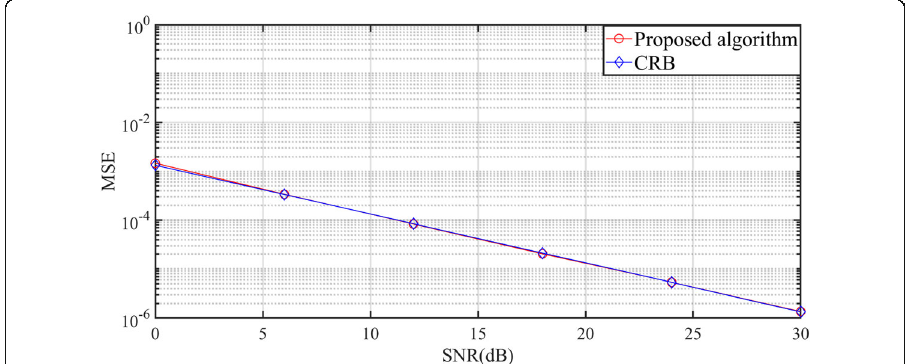
Fig. 6 The MSE performance for CFO estimation of the proposed algorithm compared with